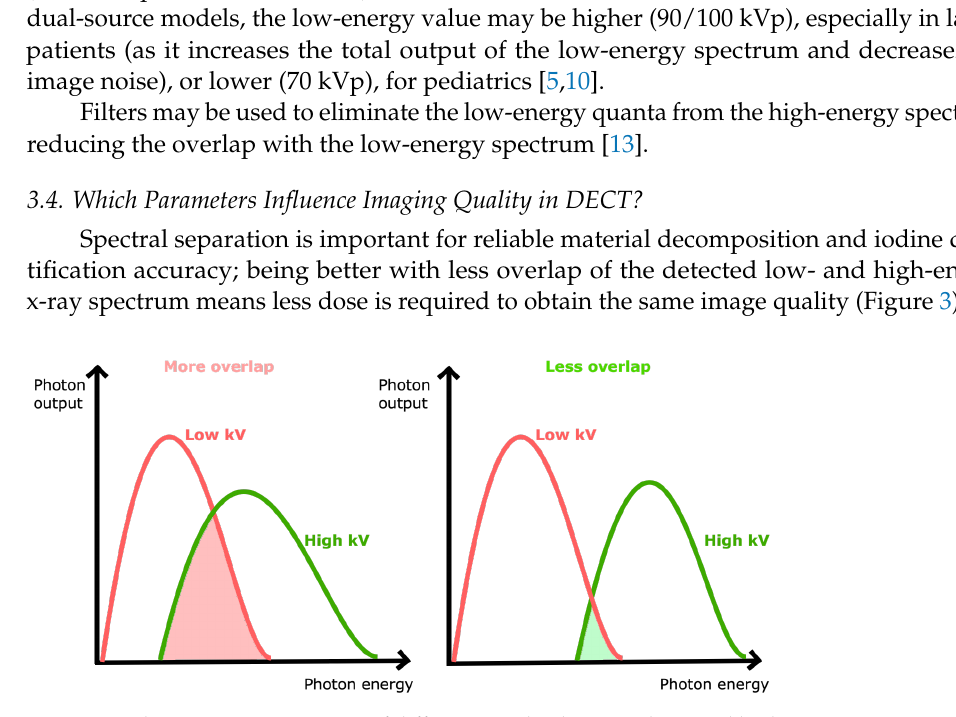
Figure 3. Schematic representation of different overlap between low- and high-energy x-ray spec- trum. Less overlap (i.e., greater spectral separation) allows better imaging quality. Less overlap (i.e., greater spectral separation) allows better imaging